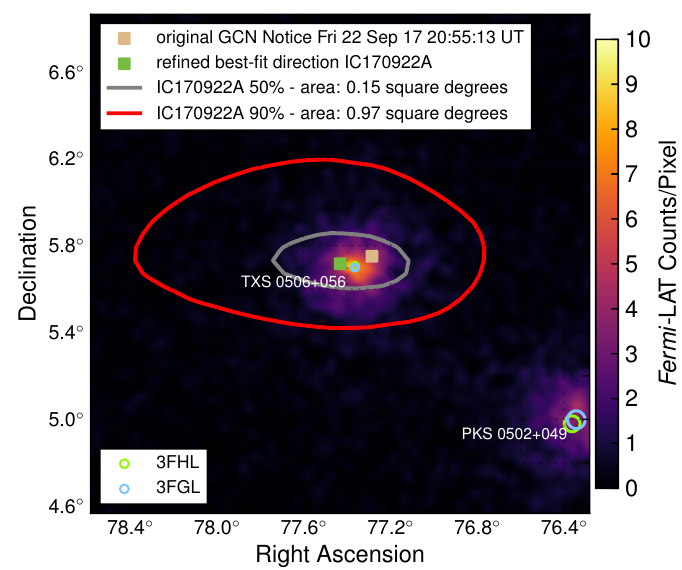
Figure 10. Sky position of IceCube-170922A overlaying the γ -ray map from Fermi LAT above 1 GeV [39]. The tan square indicates the position reported in the initial alert and the green square indicates the final best-fitting position from follow-up reconstructions [37]. Gray and red curves show the 50% and 90% neutrino containment regions, respectively, including statistical and systematic errors. Fermi -LAT data are shown as a photon counts map in 9.5 years of data in units of counts per pixel, using detected photons with energy of 1 to 300 GeV in a 2 ◦ by 2 ◦ region around TXS 0506+056. Also shown are the locations of a γ -ray source observed by Fermi -LAT as given in the 3FGL [7] and 3FHL [11] source catalogs, including TXS 0506+056. For Fermi -LAT catalog objects, marker sizes indicate the 95% confidence level positional uncertainty of the source. ( c (cid:13) American Association for the Advancement of Science. Reproduced with